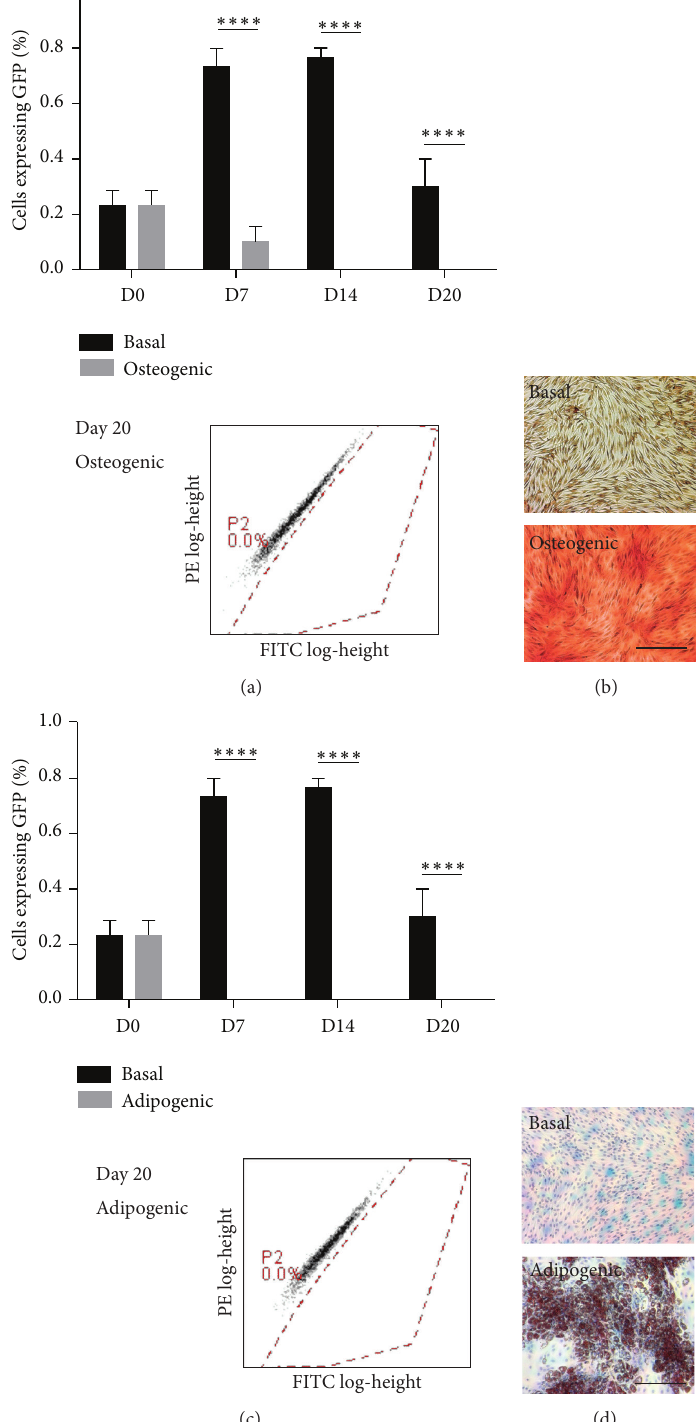
Figure 2: Endogenous Wnt signalling is not activated during 2D MSC differentiation. (a) Percentage of positively expressing human Y201 MSC-EGFP reporter cells during osteogenic differentiation as measured by flow cytometry, ∗∗∗∗ 𝑝 < 0.0001 versus basal control with representative flow cytometry plot. (b) Alizarin red staining for calcium deposition during osteogenic differentiation. Scale bar = 200 𝜇 m. (c) Percentage of positively expressing human Y201 MSC-EGFP cells during adipogenic differentiation as measured by flow cytometry, ∗∗∗∗ 𝑝 < 0.0001 versus basal control with representative flow cytometry plot. (d) Oil Red O staining for lipid droplet formation during adipogenic differentiation. Scale bar = 200 𝜇